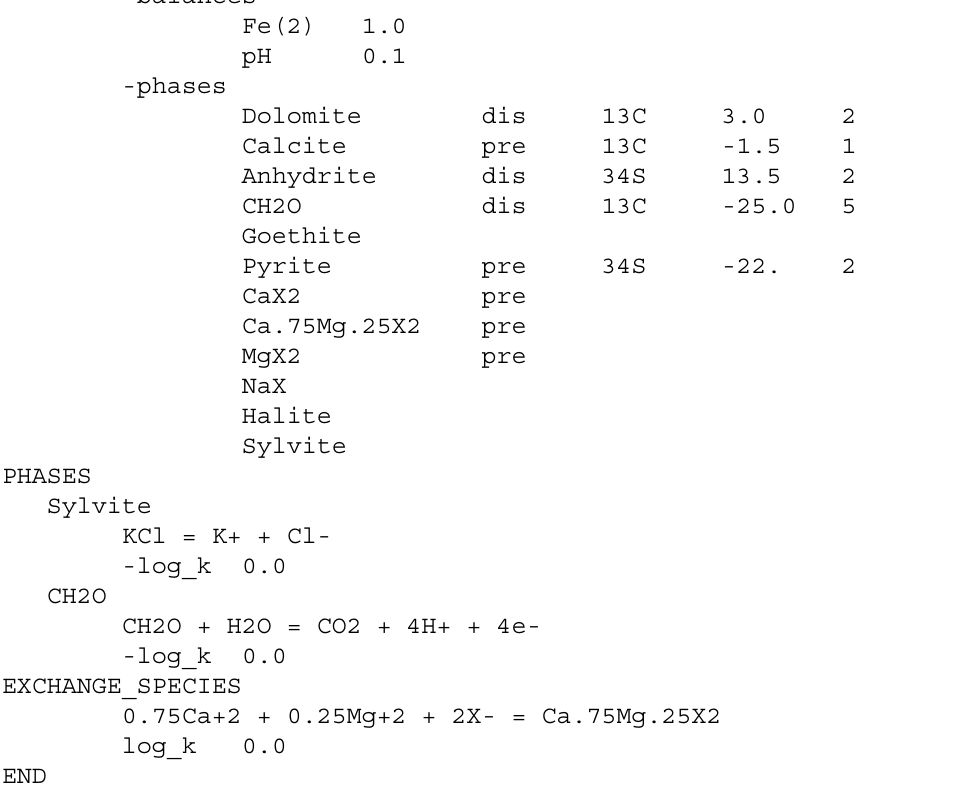
Table 53. Input file for example